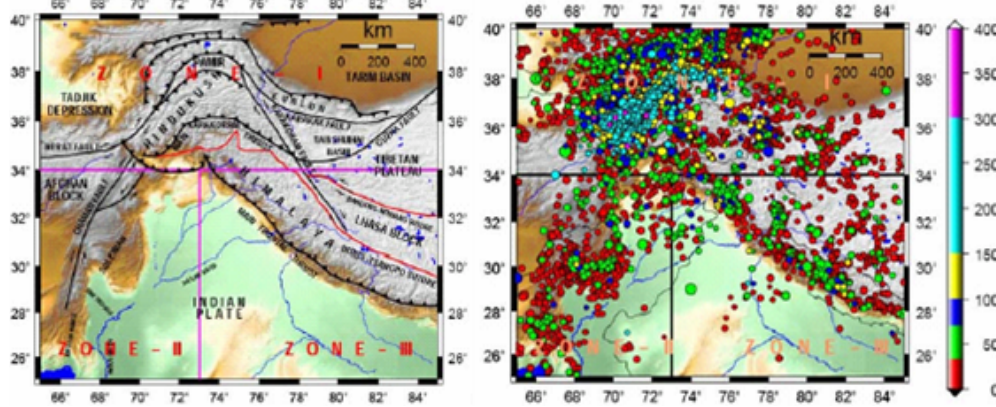
Fig. 1. It depicts tectonic map of three different regions (left figure) and seismicity map over three regions (right figure) showing vertical distribution of earthquakes during 1853–2005 (Shanker et al.,